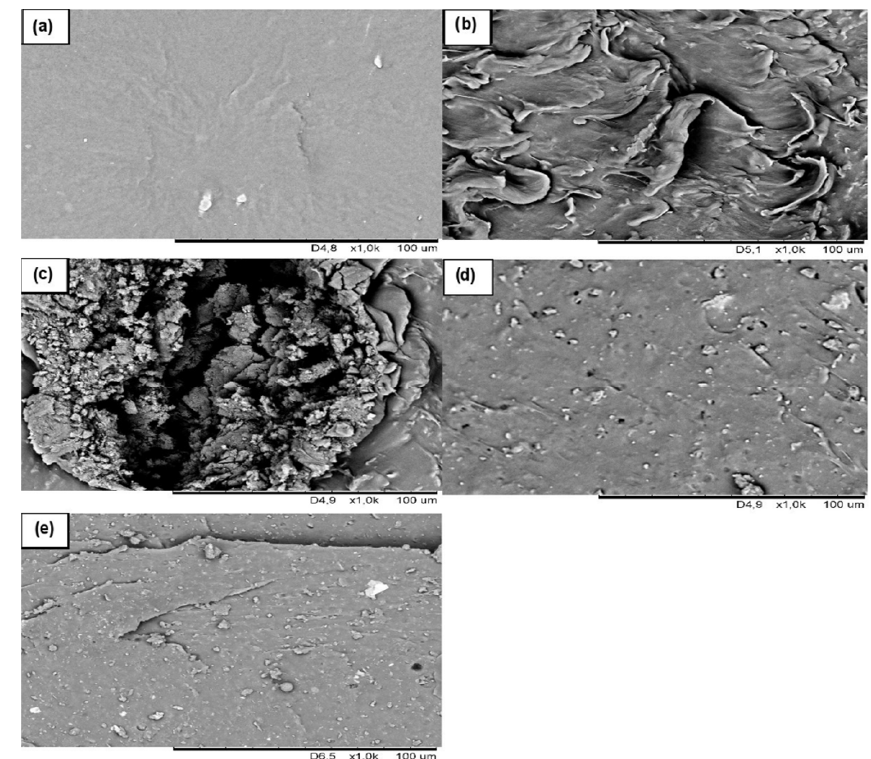
Figure 3. SEM images of the cross-section of: CR/BR/nano-Fe 2 O 3 ( a ); CR/BR/aerosil ( b ); CR/BR/ultrasil ( c ); CR/BR/chalcedony ( d ); CR/BR/sillitin ( e ).